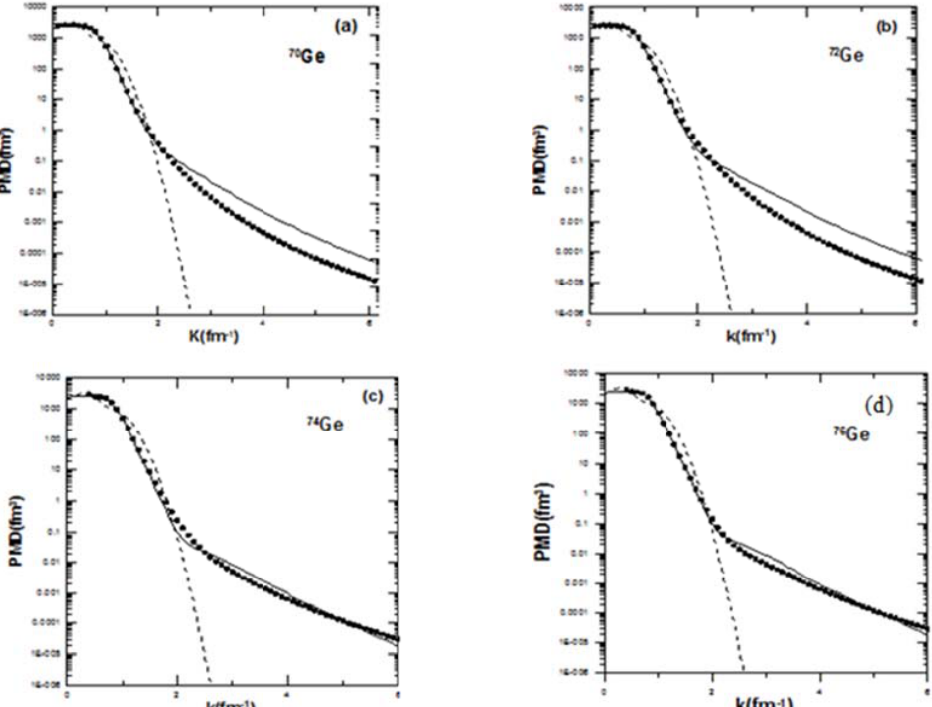
Fig. . 2: The depe long g-dashed cu calc culation usin repr resentation. PMD MD obtained and d theoretical 76 Ge e by using th